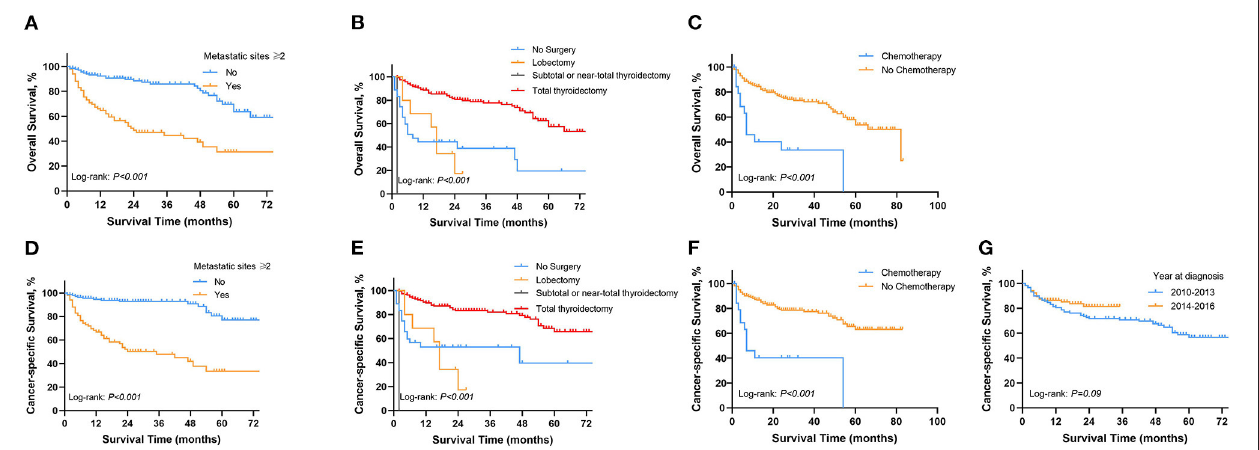
FIGURE 4 | Kaplan-Meier survival curves presenting OS and CSS in Patients with DTC diagnosed with SBM. (A) OS between metastasis sites ≥ 2 and<2. (B) OS in different surgical procedures. (C) OS of patients with and without chemotherapy. (D) CSS between metastasis sites ≥ 2 and<2. (E) CSS in different surgical procedures. (F) CSS of patients with and without chemotherapy. (G) CSS in different periods of diagnosis. OS, overall survival; CSS, cancer-specific survival; DTC, differentiated thyroid cancer; SBM, synchronous bone